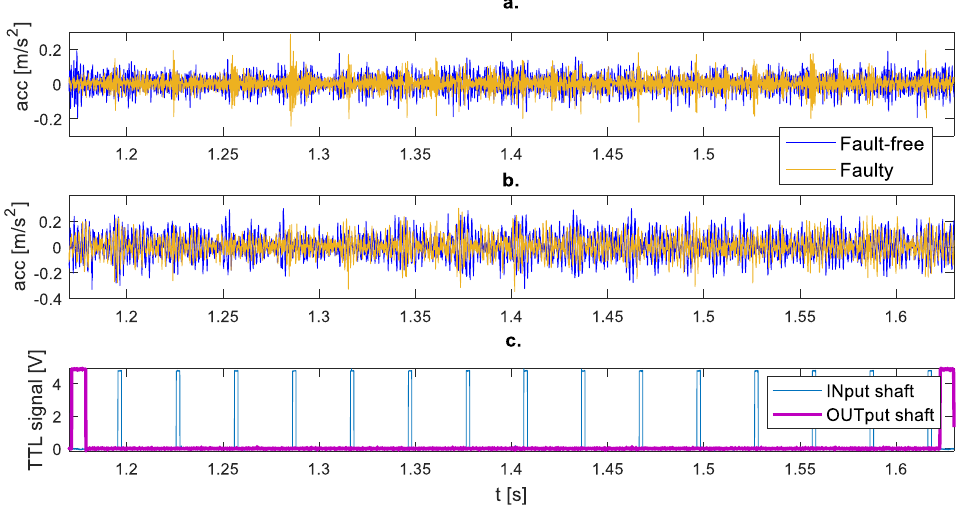
Figure 5. Vibration acceleration waveform during 1 revolution of the output shaft at a speed of 2000 rpm and a load of 30 Nm: ( a ) Vertical vibrations, ( b ) Horizontal vibrations, ( c ) Tachometers signals. It is worth noting that the rotational speed of the shafts during gear operation is floating, even at a fixed rotational speed, which can be seen in Figure 6.